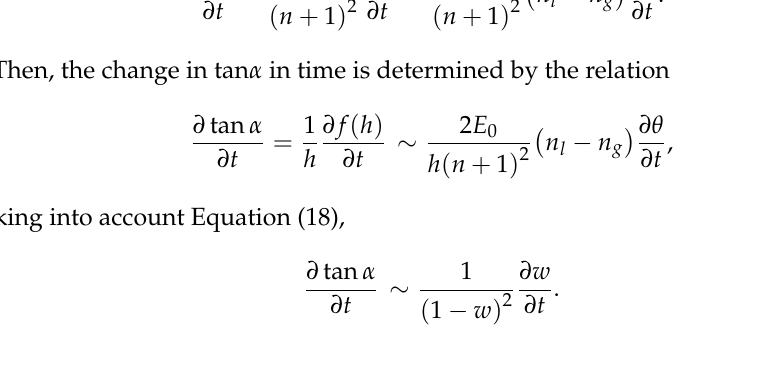
Figure 14. Polynomial functions approximating the derivatives of relative reflectivity δ (Equation (15)) for experiment 1 at different points in time from the beginning of drainage. The following colors were chosen to indicate the time: immediately after moistening—red; after 0.1 h—blue; 0.2 h—green; 0.4 h—pink; 3.5 h—orange; after 4.5 h—olive. The arrows indicate the positions of the local maxima of the derivatives δ ; h is the depth measured from the top surface of the sand layer. Figure 14 shows that the derivative of the relative reflectivity with respect to depth immediately after soaking has a local maximum at a depth of 0.025 m and slowly de- creases with increasing depth. This is explained by the fact that the GPR studies were